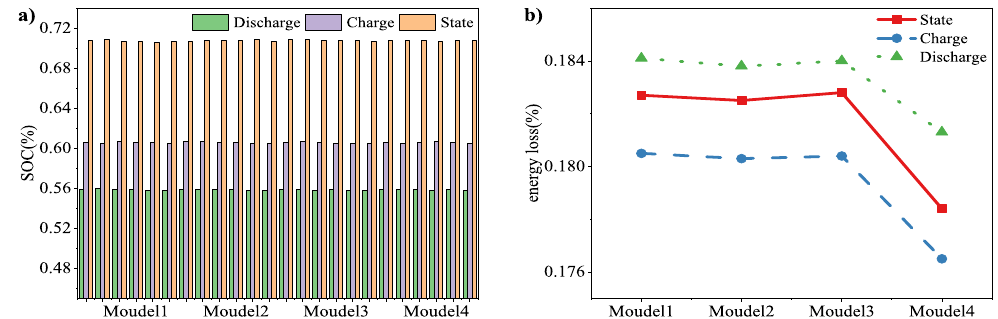
Figure 13. Comparison of equilibrium results: ( a ) Battery SOC values at the end of equilibrium for the four patterns; ( b ) Energy